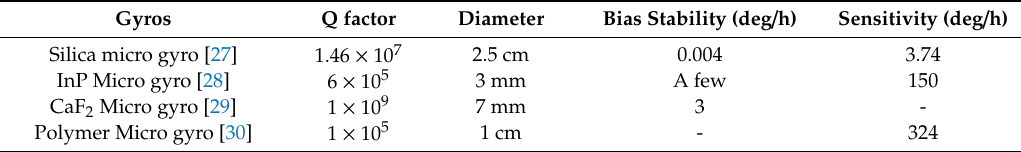
Table 1. Basic features of WRRs already used in MOG prototypes.